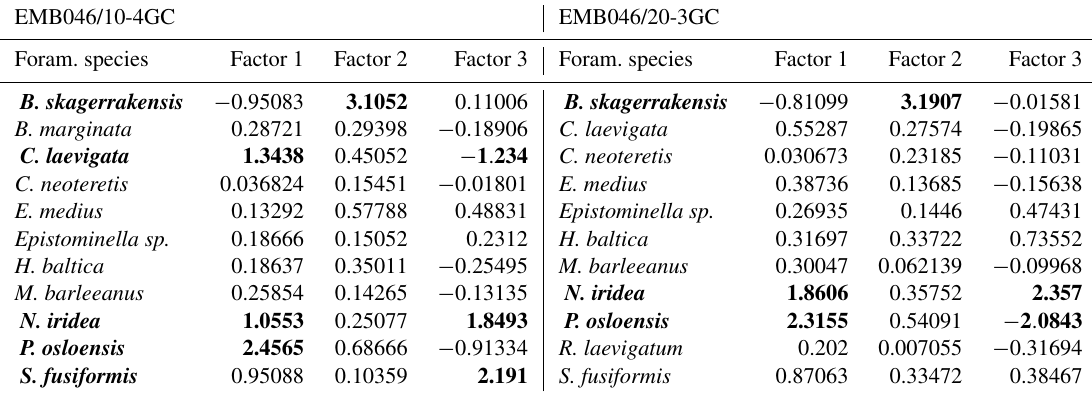
Table 4. The varimax scores for factors 1–3. The bold numbers indicate foraminiferal species with absolute value of factor scores >1. EMB046/10-4GC EMB046/20-3GC Foram. species Factor 1 Factor 2 Factor 3 Foram. species Factor 1 Factor 2 Factor